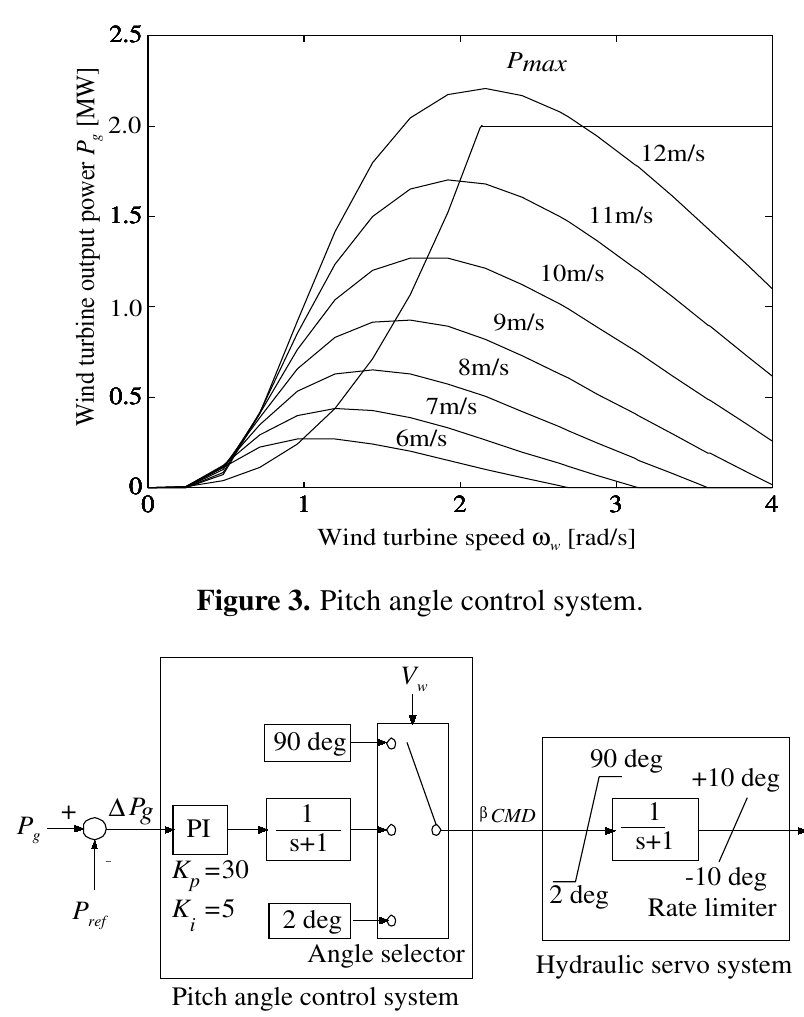
Figure 2. WECS output power characteristics.